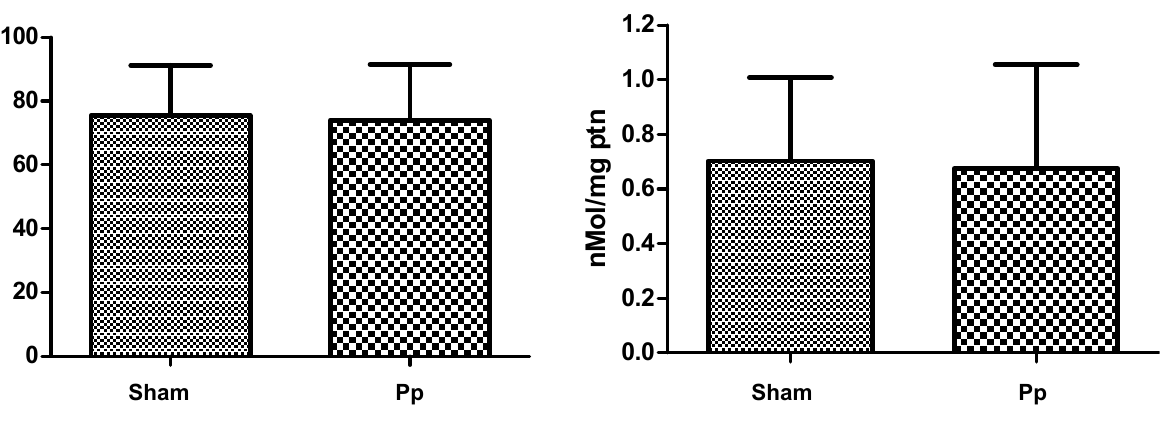
Figure 2 - Malondialdehyde concentration in renal tissue of rats submitted to 8 mmHg pneumoperitoneum for 3 hours. The bars represent men and standard deviation. The means are not significantly different (t test, p= 0.871).